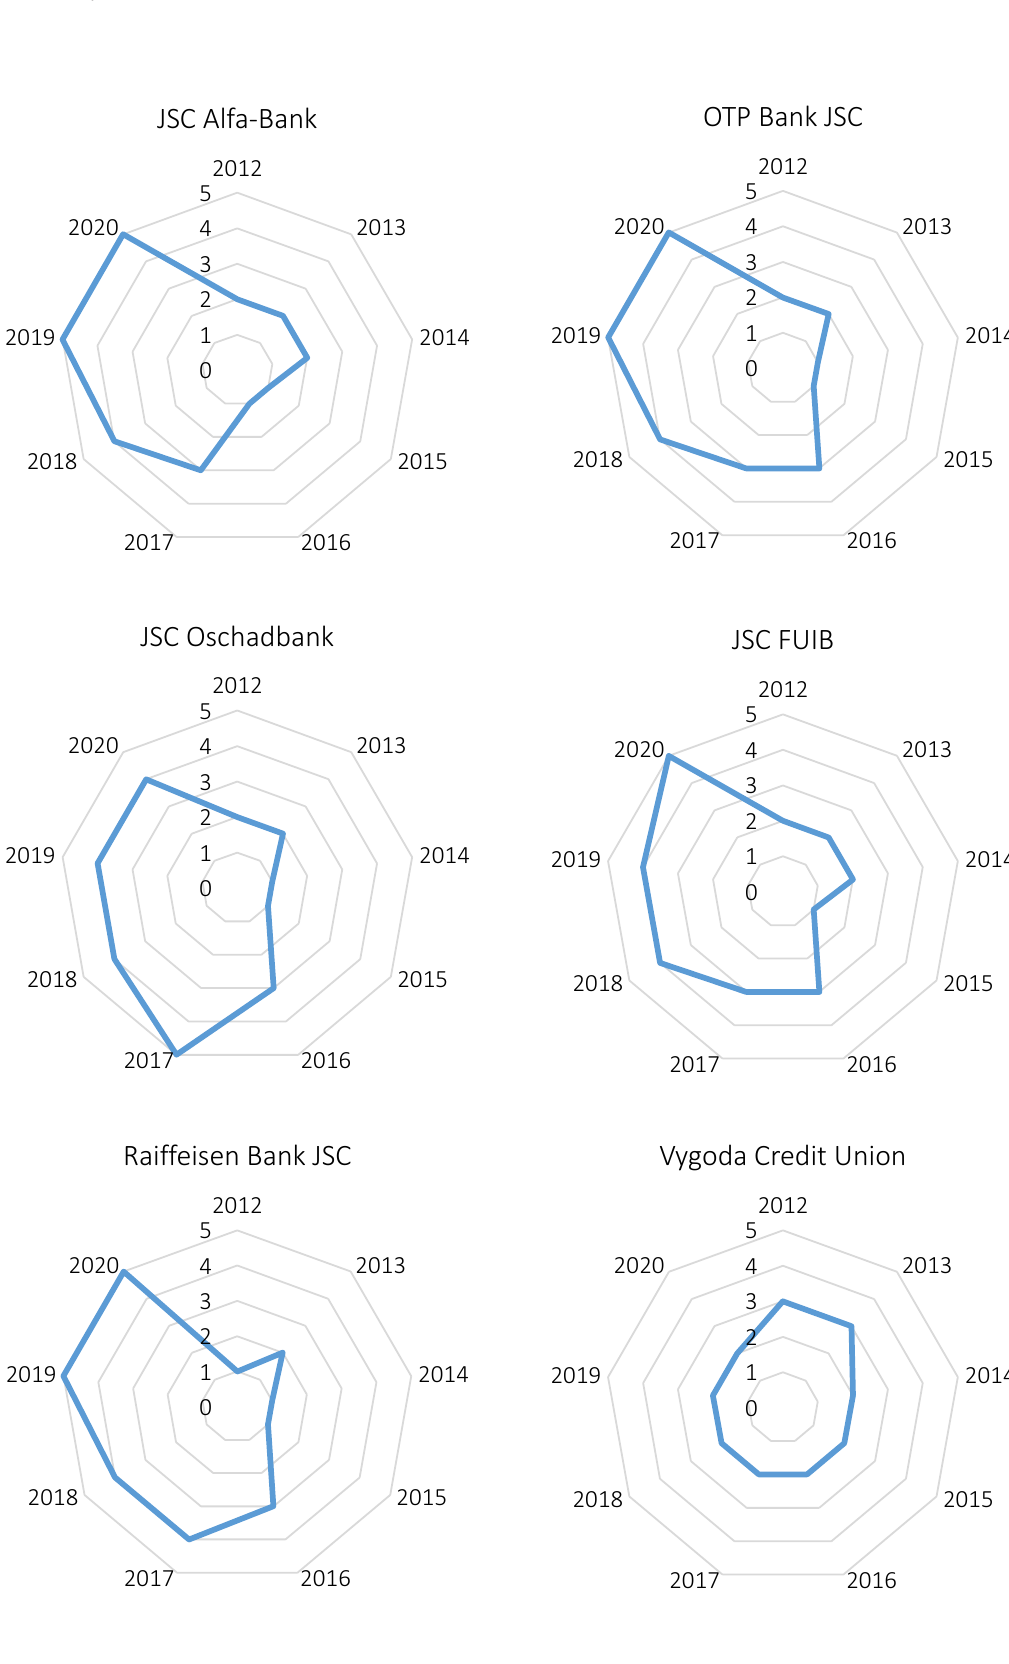
Figure A1 (cont.). Development patterns of financial intermediaries’